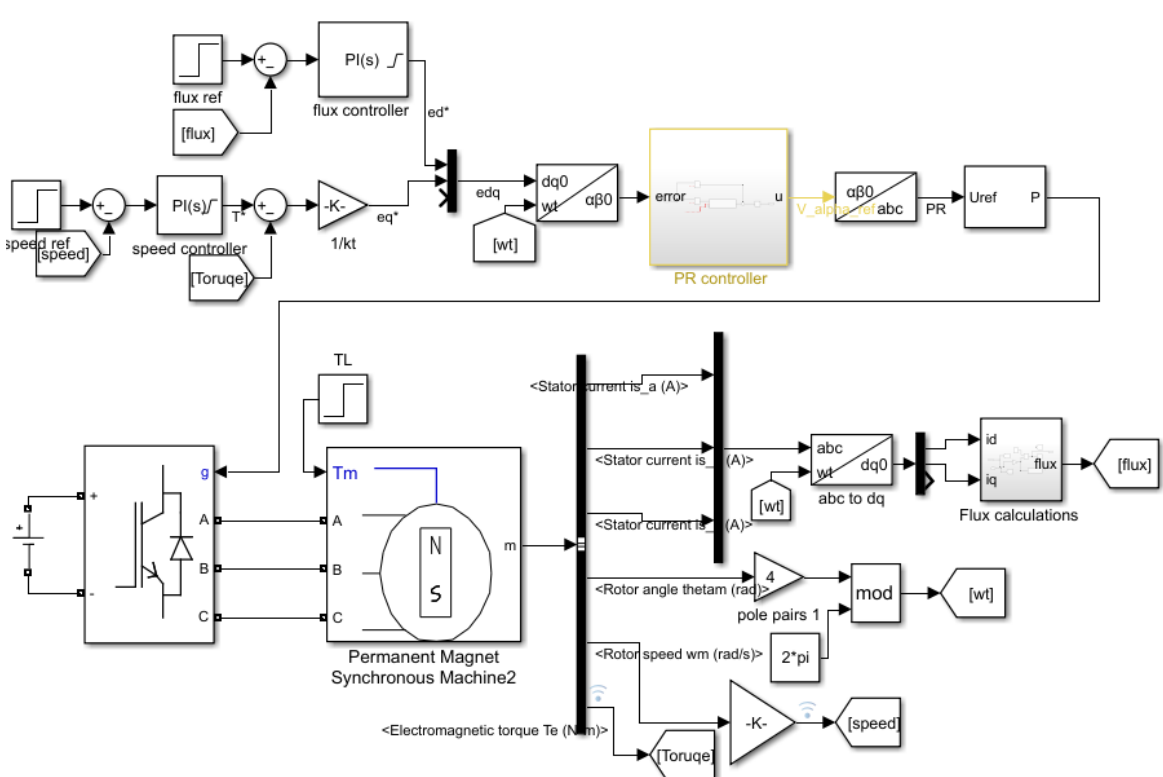
Figure 4. The Simulink model using the proposed control